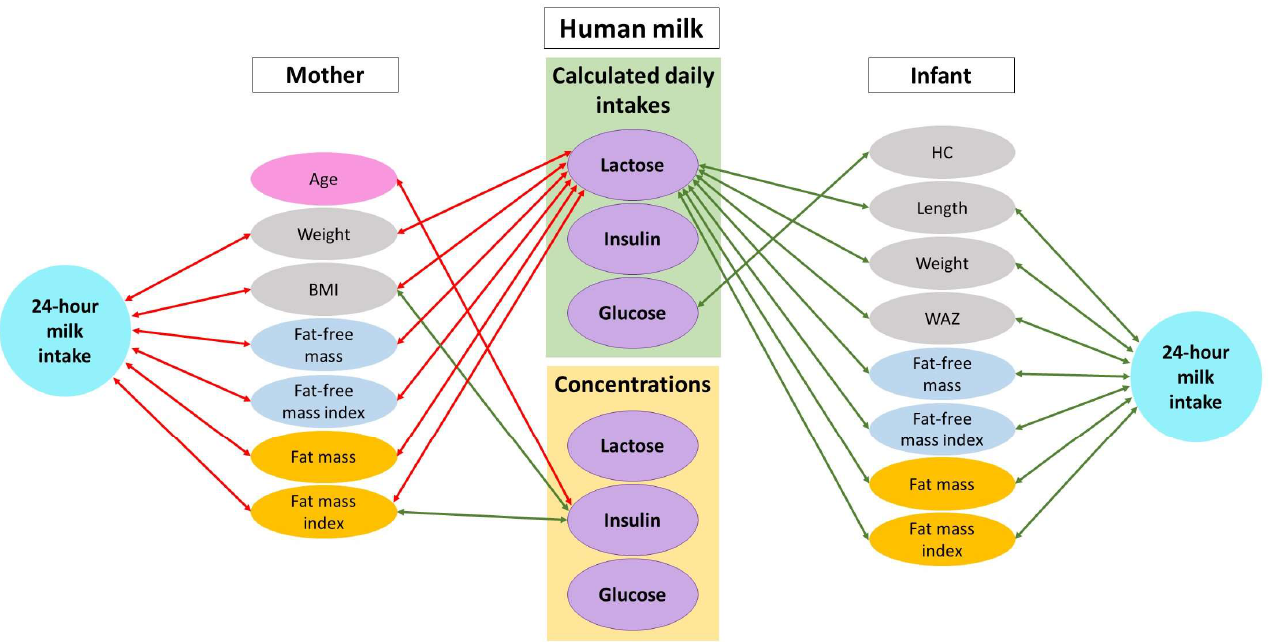
Figure 1. Possible lactocrine programming of the infant body composition as researched. Green arrows indicate positive associations and red arrows—negative associations. BMI—body mass index; HC—head circumference; WAZ—weight-for- age